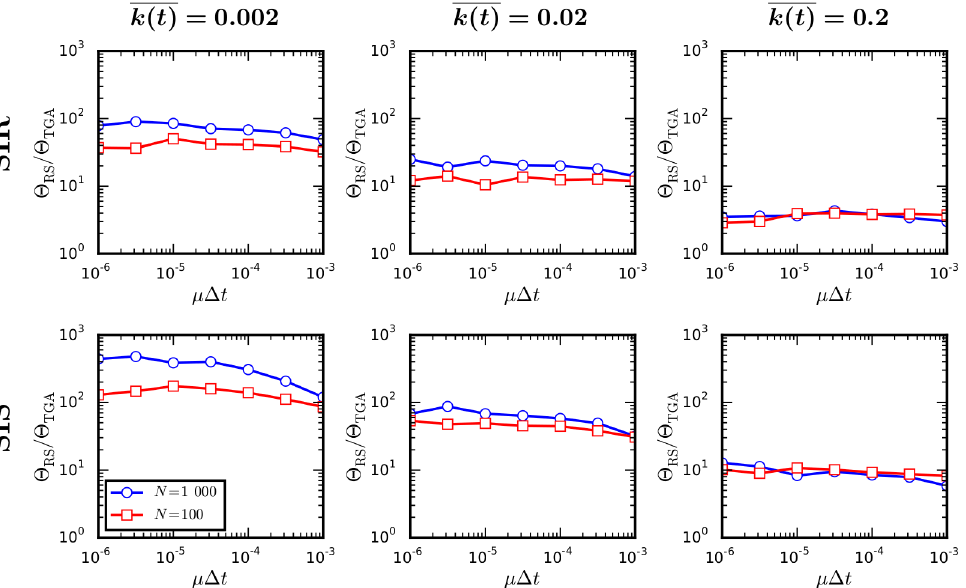
Fig 4. Comparison of the speed of the temporal Gillespie and the rejection sampling algorithms. Ratio between computational times Θ RS and Θ TGA per single realization of a spreading process using rejection sampling and the temporal Gillespie algorithm, respectively: (A) for a SIR process and (B) for a SIS process on networks with different mean degree, k ð t Þ ([for empirical contact networks, k ð t Þ(cid:9) 0 : 004 (cid:5) 0 : 07 (Table 1)]. Networks consisted of N = 100 or N = 1000 nodes, with activities a η z z z (cid:5) 3 : 2 z i = i and i 2 [0.03, 1); a node formed two contacts each time it was active. For i (cid:4) i for data), μ Δ t (cid:9) 3 (cid:10) 10 − 5 corresponds to a recovery time of roughly one week, typical of fl u-like diseases. The infection rate was β = 10 3 μ for networks